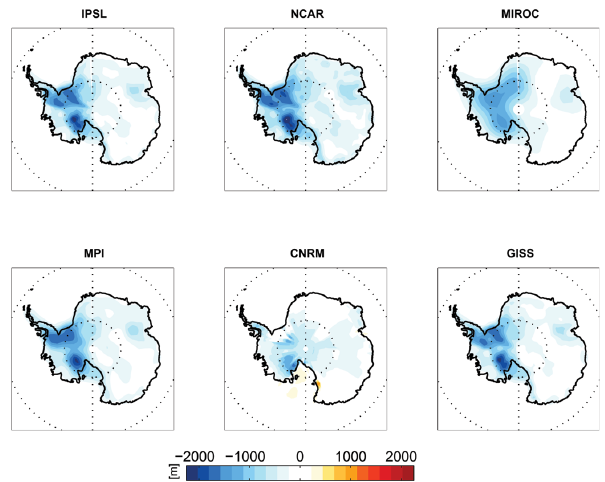
Fig. 1. LGM ice sheets for the six models included in the present analysis: altitude PI–LGM difference. This is a reconstructed dif- ference using surface pressure, as topography was not available for all models. Units are in equivalent-meters, using a height-scale of